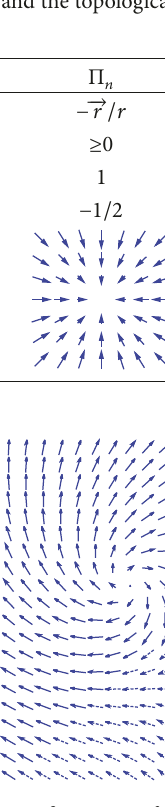
Figure 3: Dipole configuration with 𝑆 = 1 . The small blue arrows 󳨀→ 󳨀→ 𝑞 = 𝑛( r ) sin 𝛼(𝑟) of the 𝑄 -field in an show the imaginary part arbitrary plane through the centers of both solitons. Full arrows correspond to 𝑞 0 ≤ 0 and dashed arrows to 𝑞 0 ≤ 0 .